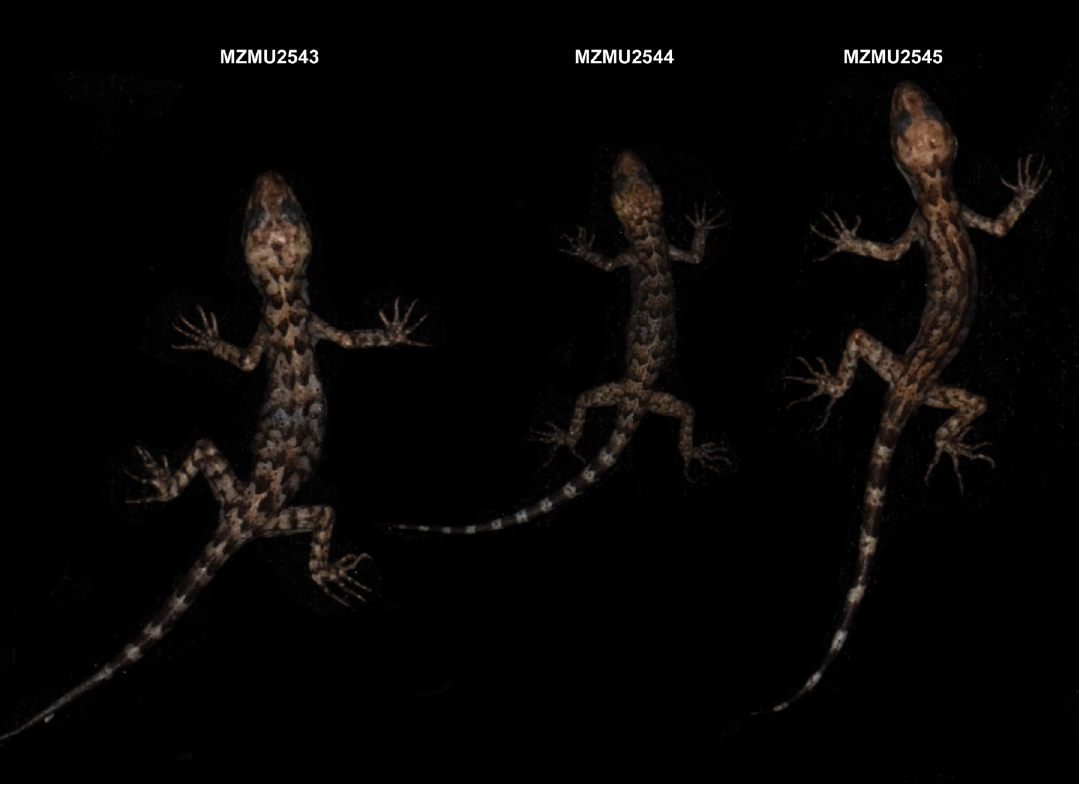
Fig. 6. Type series of Cyrtodactylus exercitus sp.